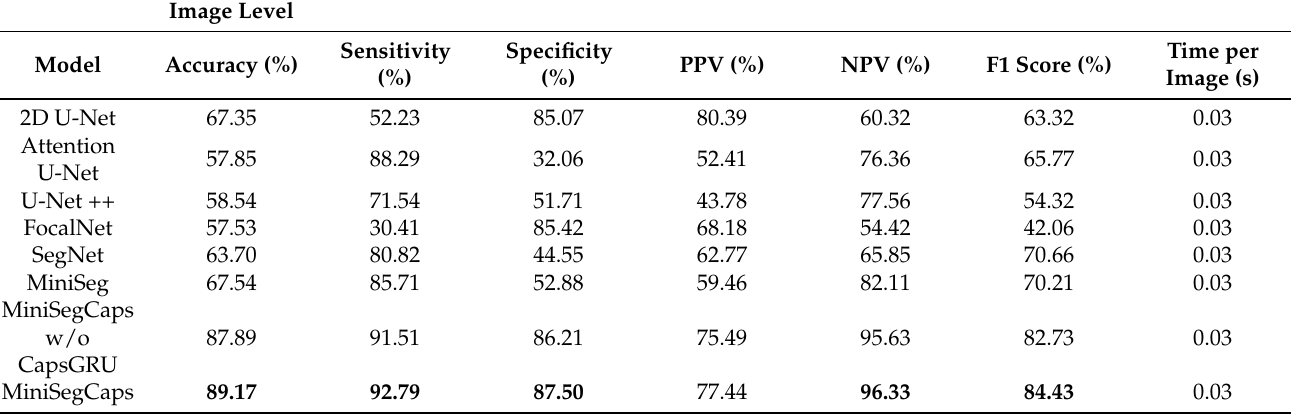
Table 7. Comparison of the image-level performance between our method and baseline methods in prostate cancer classification on PI-RADS ≥